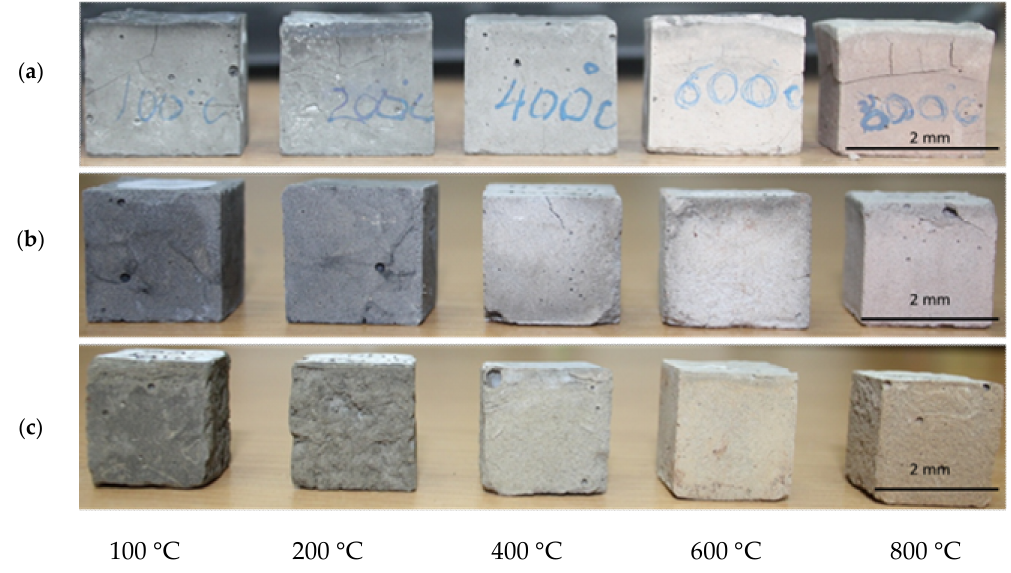
Figure 7. Physical configuration of the fly ash-based geopolymer specimens after thermal resistance test. ( a ) GB-1; ( b ) GB-2; ( c ) GB-3.